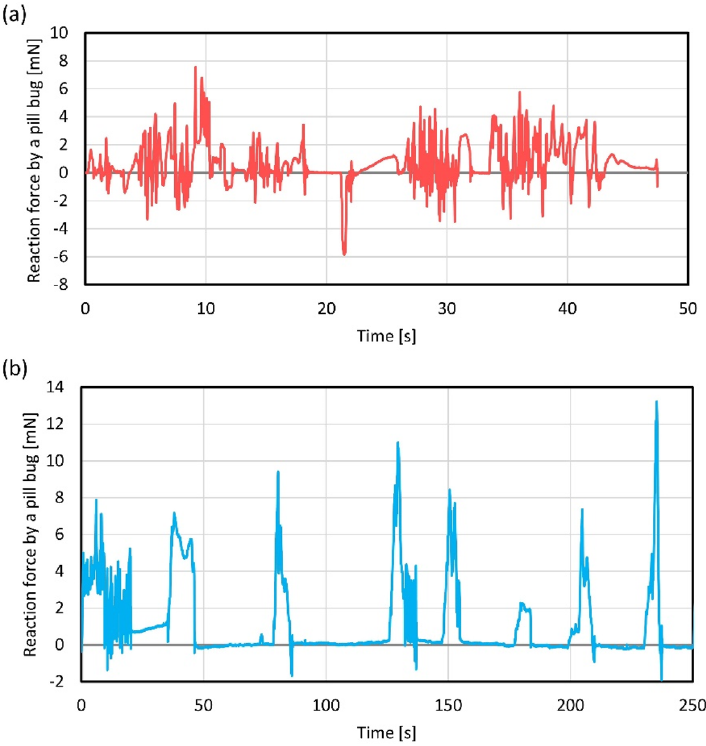
Figure 5. Force measurement of a pill bug through active sensing by a microfinger. ( a ) Measured leg force in accordance with time. ( b ) Measured abdominal force in accordance with time. The measured leg force was less than 10 mN, whereas abdominal force exceeded 10 mN. The frequency of each motion showed different tendency.